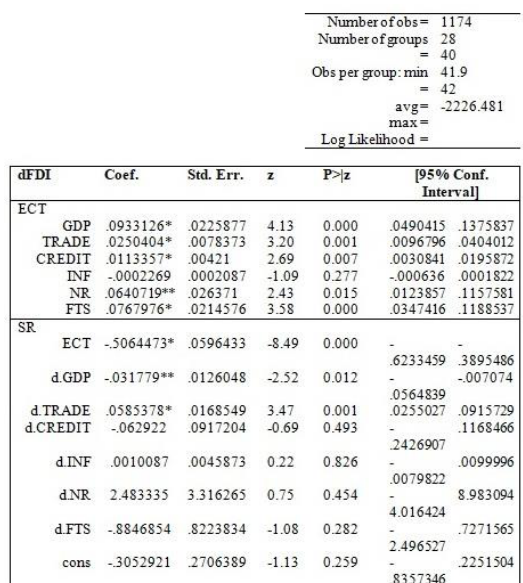
Table 8: PMG Estimator Results